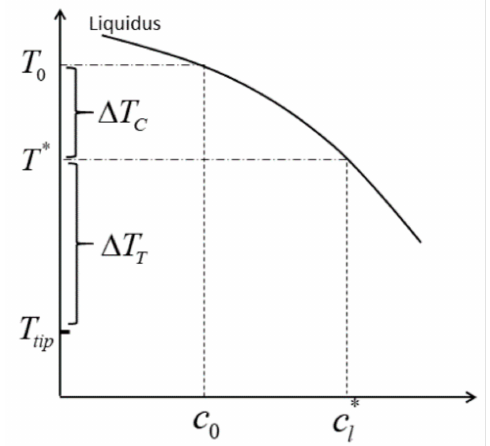
Figure 11. Schematic illustration of diffusional undercooling, ∆ T C , and thermal undercooling, ∆ T T , where c 0 is the initial alloy concentration, c ∗ and T tip are the liquid concentration and temperature at l the tip of the cell,